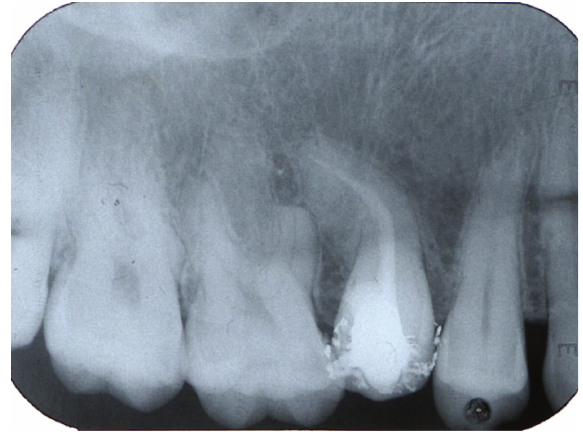
Figure 1: Initial periapical radiograph showing external apical root resorption resulted from the severely curved root of the adjacent premolar.